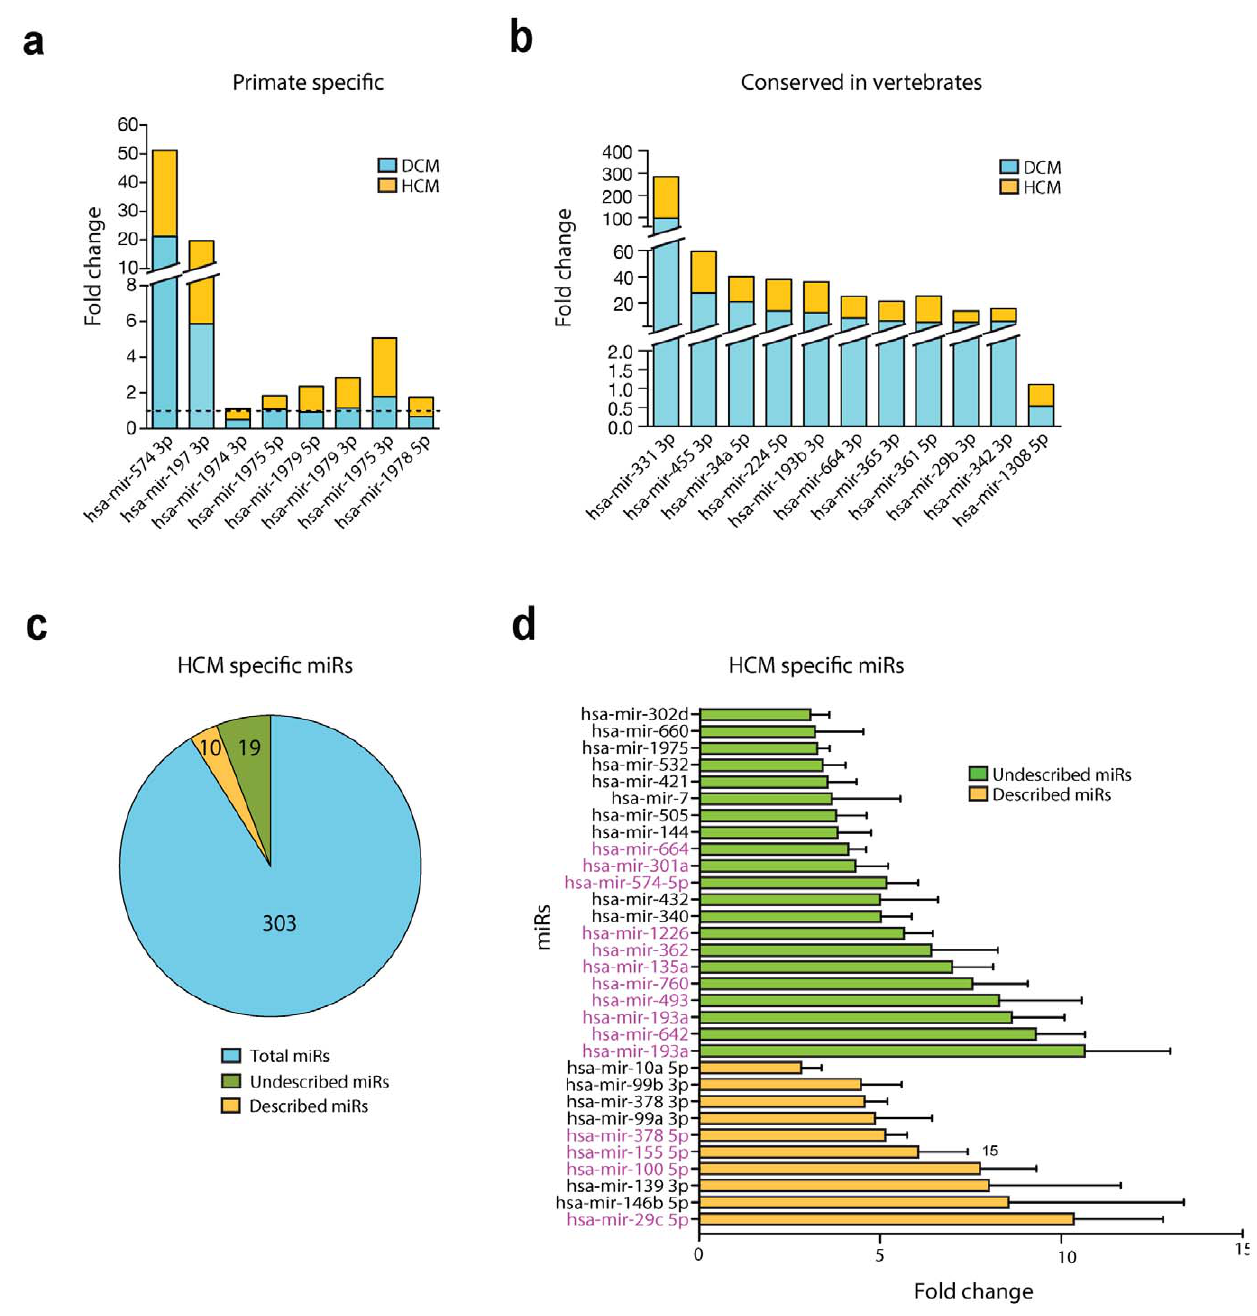
Figure 3. Hypertrophic cardiomyopathy-specific microRNA expression pattern. From the most differentially regulated microRNAs in the DCM and HCM libraries, 8 are specific for primates and conserved between primates ( A ) and 11 are highly conserved amongst vertebrates ( B ). C , From a total of 332 microRNAs detected in the HCM library, 29 were HCM-specifc, from which 10 had been previously described in profiling studies and 19 remain to be described. D , Relative abundance of HCM-specific microRNAs that were detected, or not, in previous profiling studies. MicroRNAs that are significantly expressed between HCM and DCM libraries are depicted in purple.